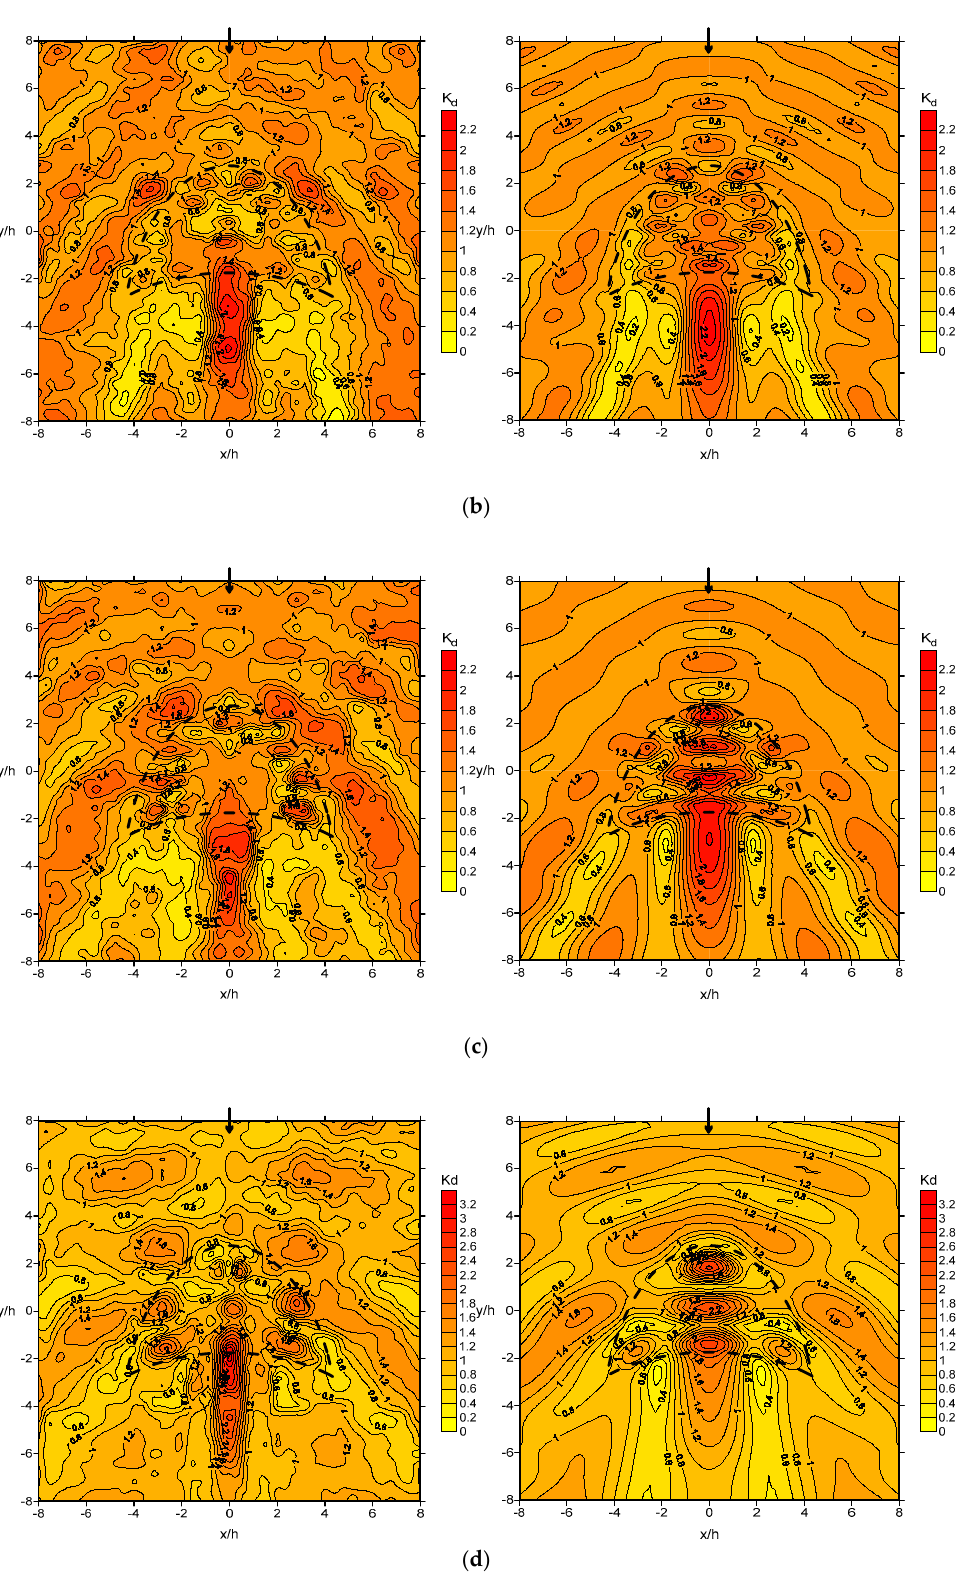
Figure 5. Comparison of the experimental (left) and numerical (right) wave fields for wave conditions of ( a ) σ 2 h / g = 3.577, ( b ) σ 2 h / g = 2.012, ( c ) σ 2 h / g = 1.288, and ( d ) σ 2 h / g = 0.894 at normal